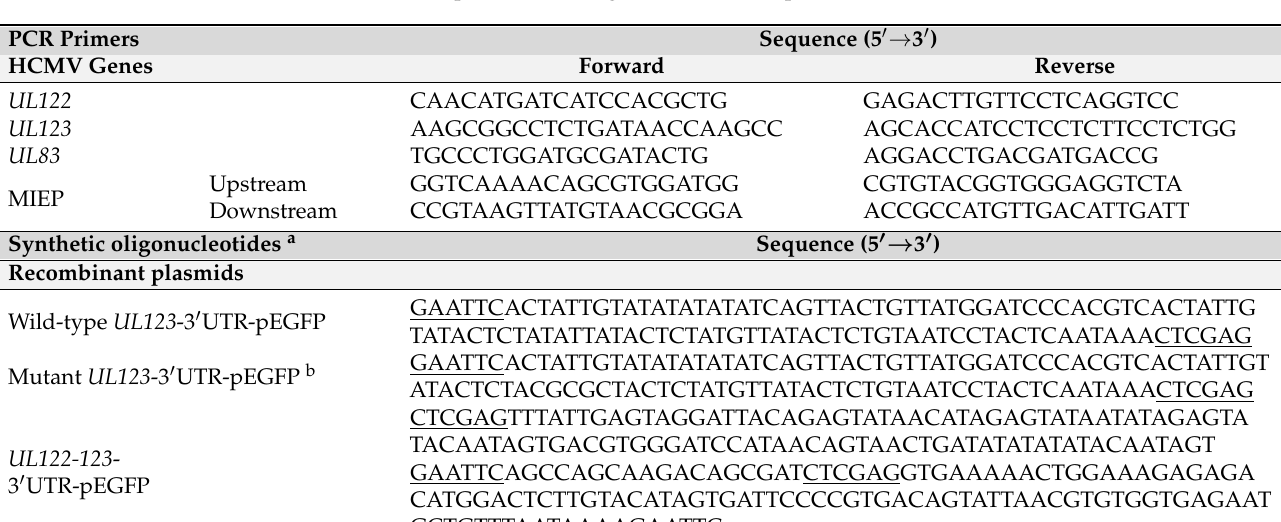
Table 1. PCR primers and oligonucleotides for